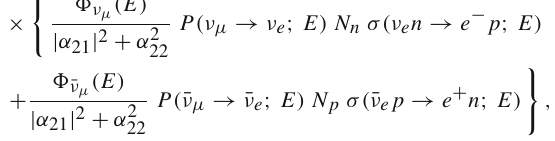
of the T2HK plus a 10 kton water Cerenkov detector at Oki, respec- tively. For comparative study, we show in the lower-left a subplot for a plan of the T2HK plus a 10 kton water Cerenkov detector at Kamioka. min χ 2 = 1 , 4 , 9 on the red solid, blue dashed, and purple dot-dashed contours, respectively